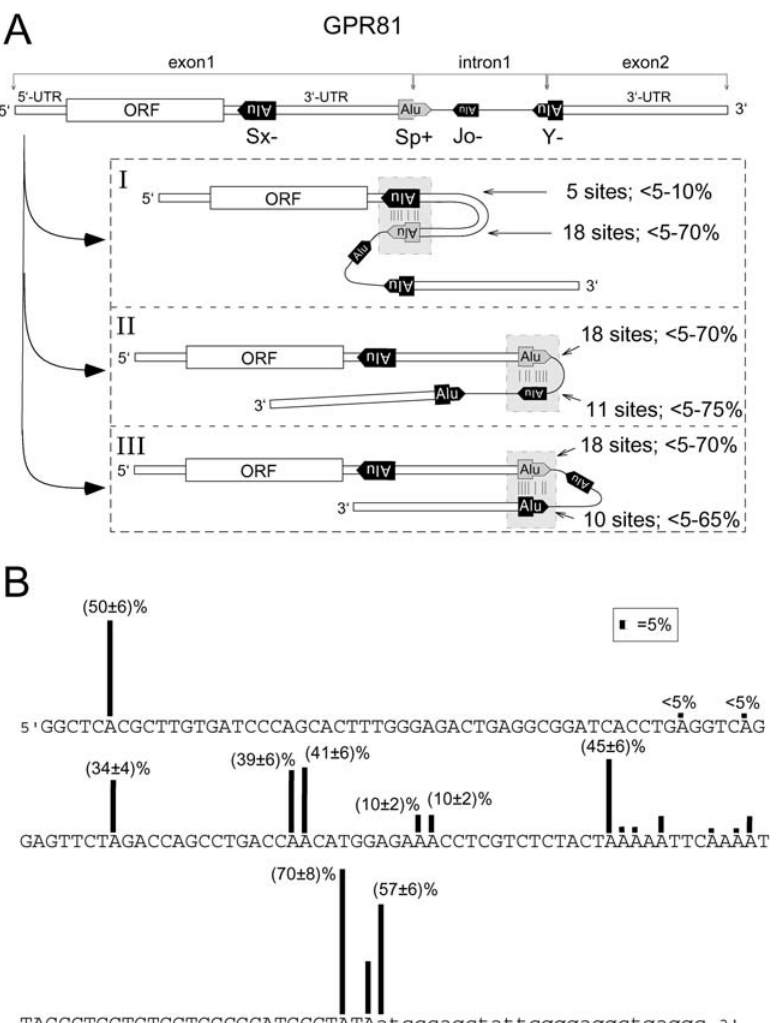
Figure 5. Editing of Alternative Foldback Structures of GPR81 Pre-mRNA (A) The position and orientation of all four Alu elements in GPR81 pre-mRNA is indicated. Three alternative Alu pair- ings (I–III) are predicted and experimen- tal editing analysis indicates that all three do form in vivo. ORF, open read- ing frame; *, editing sites. (B) Editing analysis of AluSp þ in GPR81. Percentages of editing in human brain are indicated. The exonic sequence appears in capitals. The edited AT dinucleotide that becomes a splice donor site is underlined. DOI: